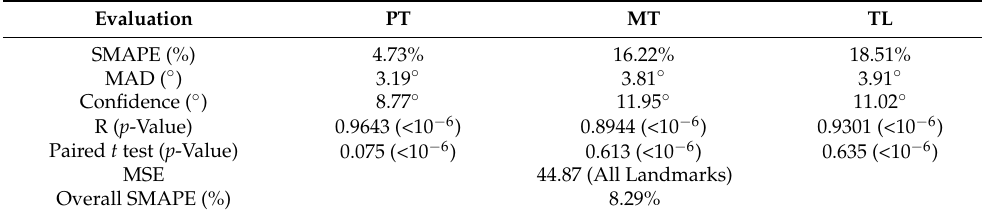
Table 3. Statistical comparison of the manual ground truth and our automatic method on the public AASCE MICCAI 2019 challenge dataset.